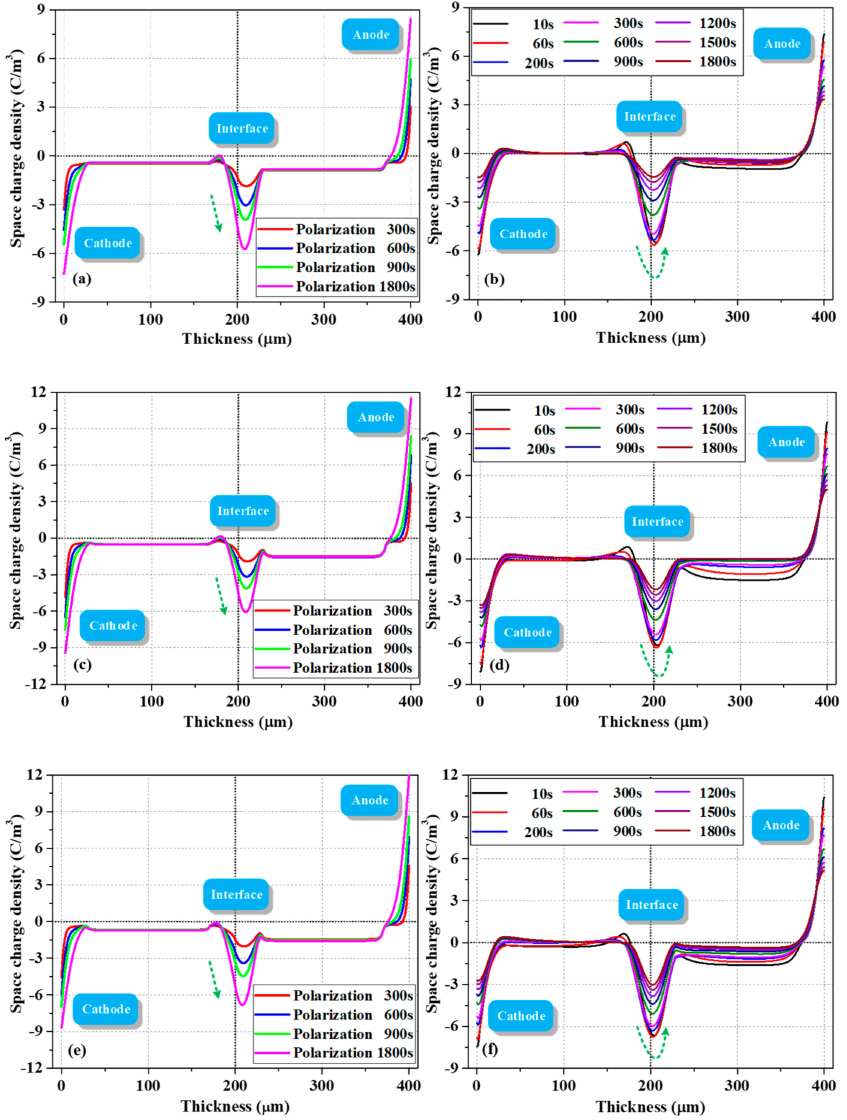
Figure 8. Simulation results of charge during polarization (left) and depolarization (right) processes of PET–PET samples, which were thermally aged for ( a , b ) 720, ( c , d ) 2100, and ( e , f ) 2900